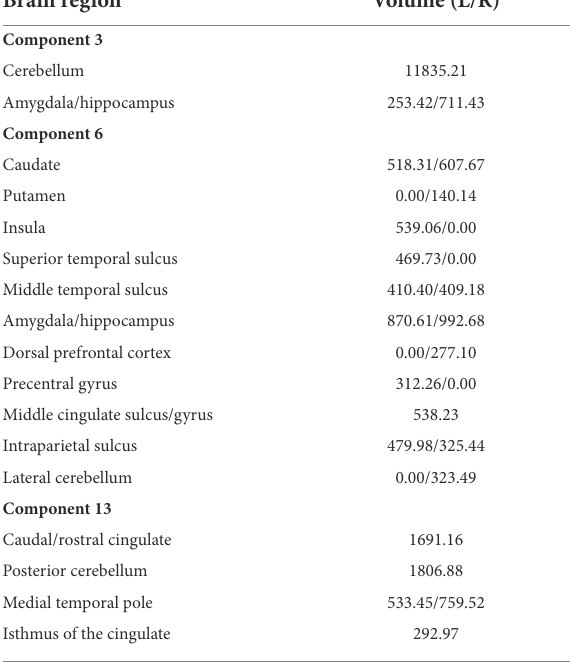
TABLE 1 Brain region gray matter volumes for SBM components 3, 6, and